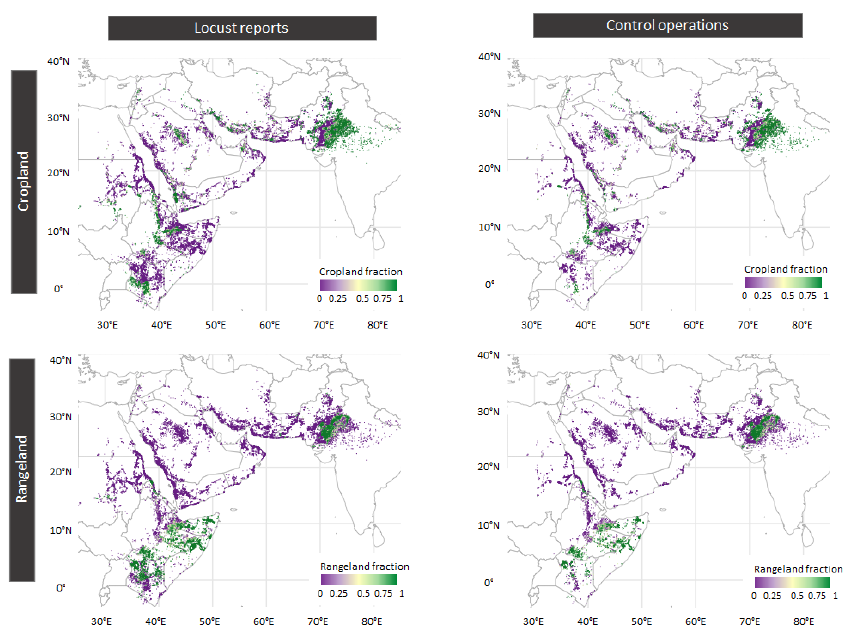
Figure 5. The fraction of land used as cropland and rangeland for pixels with locust reports and control operations. It should be noted that timing of locust infestations with crop production and pasture availability are not reflected in the above